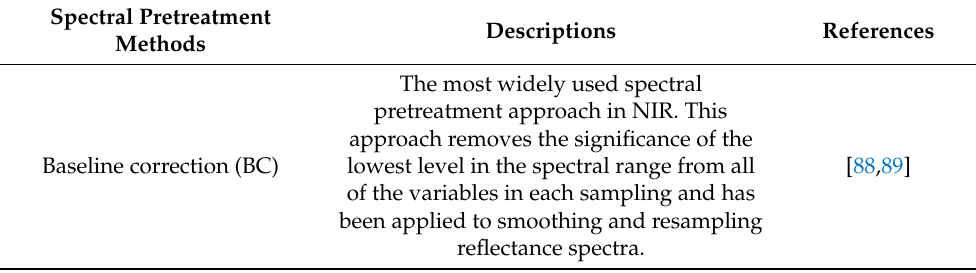
Table 2. Various spectral pretreatment methods with